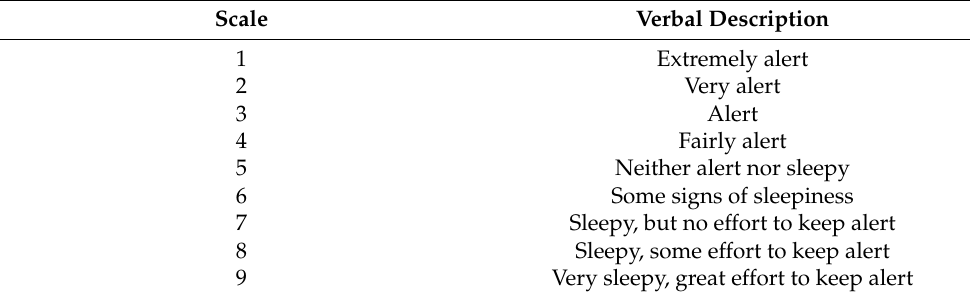
Table 1. Karolinska sleepiness scale, adapted from [19].